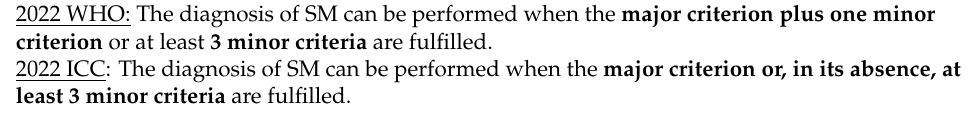
Table 3. Diagnostic criteria for systemic